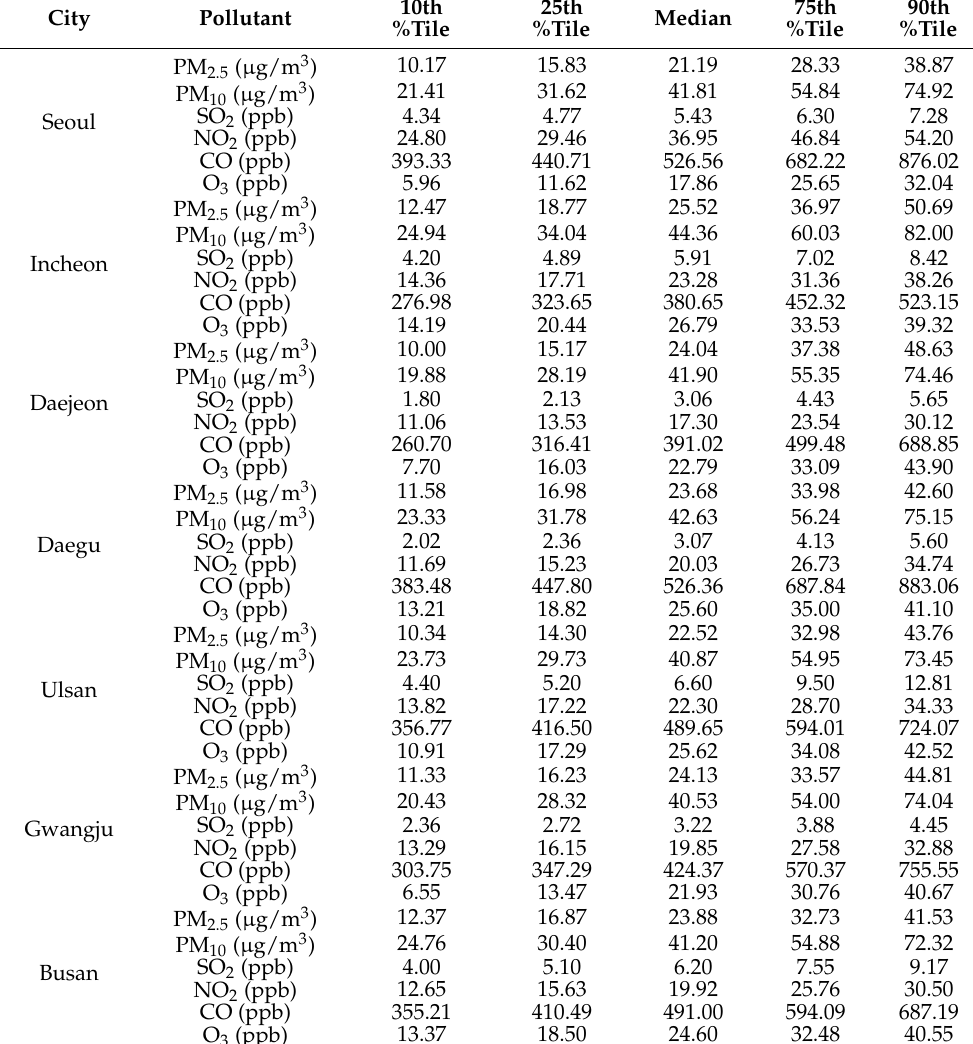
Table 2. Distribution of air pollutant levels in seven metropolitan cities in South Korea,